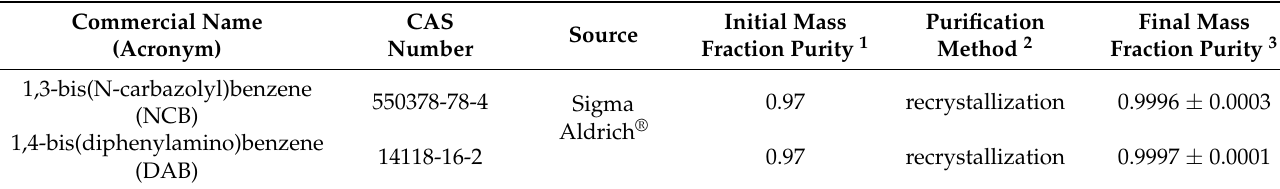
Table 1. Chemical data, source, and purities of the compounds used in this work.